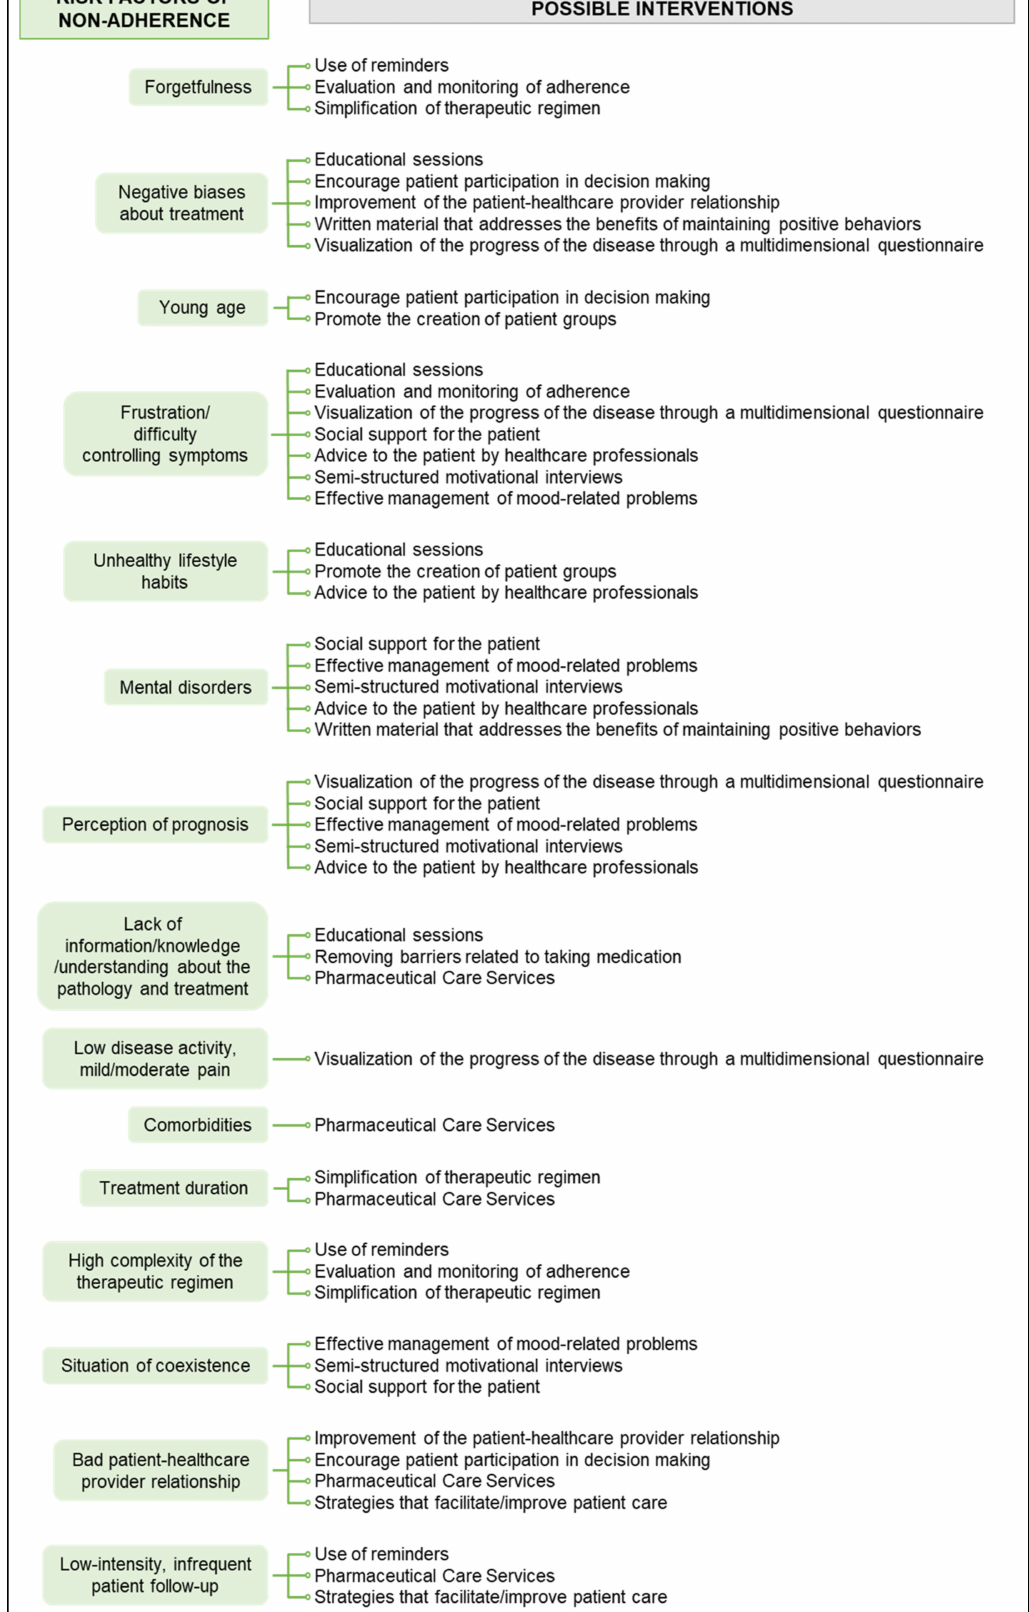
Figure 2. Map of risk factors and possible interventions to improve